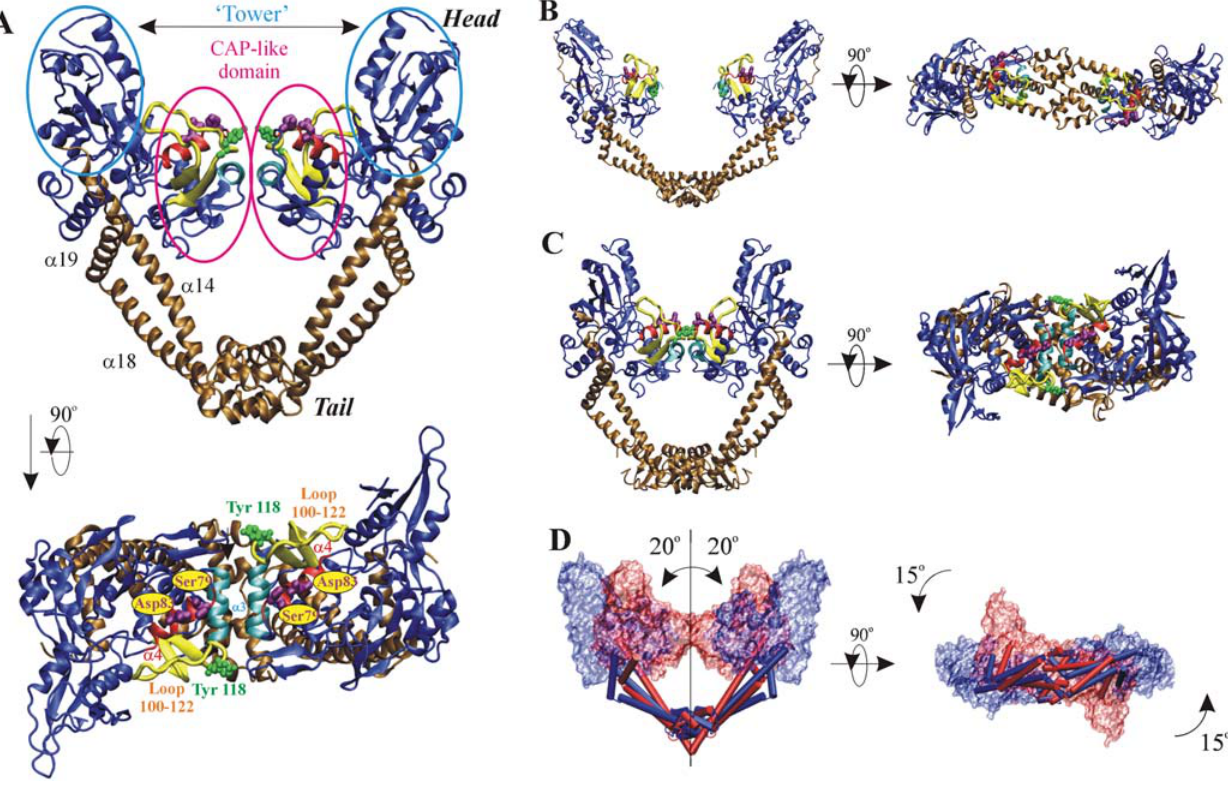
Figure 2. Structure of the ParC55 dimer and illustration of structurally related E. coli ParC and GyrA proteins. (A) Orthogonal views of the ParC55 biological dimer from S. pneumoniae . (B) Structure of the N-terminal region of E. coli ParC (18) (1ZVU) equivalent to ParC55 fragment. (C) Structure of the N-terminal fragment (GyrA59) of E. coli GyrA [19] (1AB4). In (A), (B) and (C) the ‘towers’ and the CAP-like domains are shown in ice blue; the ‘tails’ along with adjacent helices a 14, a 18 and a 19 are in ochre; the helix a 4 in red; the helix a 3 in cyan and the 100-122 loop in yellow. The active-site tyrosines are shown in green. Residues Ser 79 and Asp 83 responsible for drug-resistance upon mutation are in purple. (D) Schematic conversion of ParC55 from ‘closed’ (red) to ‘open’ (blue) conformation on the basis of the E. coli ParC structure. Panels were rendered using VMD [50] and